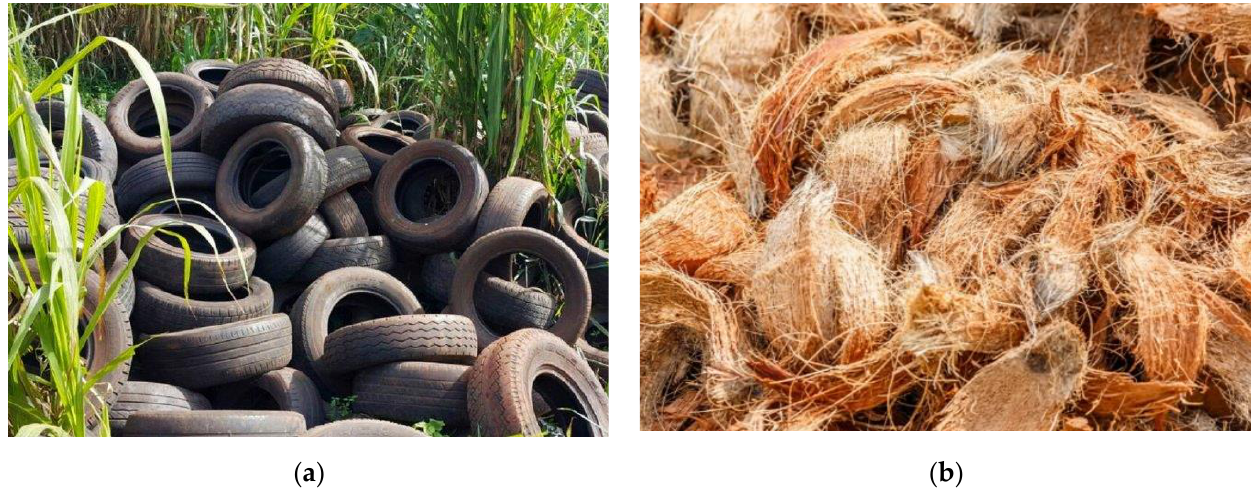
Figure 1. Open dumping of: ( a ) Waste tire; ( b ) Coconut coir fibers; (source: World Wide Web).